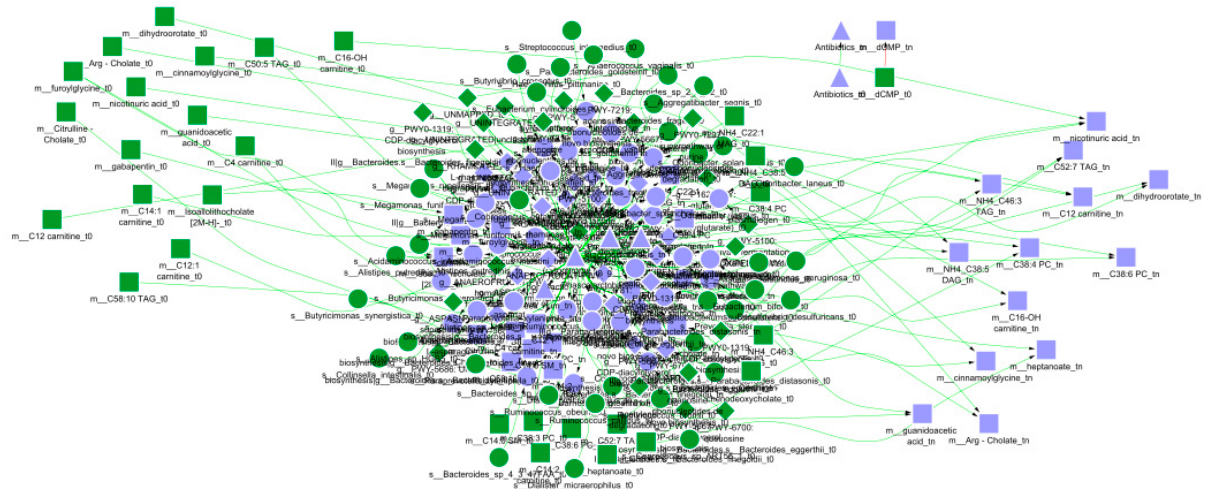
Figure 7. Learned DBN with ‘restriction matrix’ constraints on the top-50 best features per omic type. Green nodes represent time slice t i and purple nodes the consecutive t i +1. Metabolite nodes are represented by squares, species (taxa) by circles, clinical variables by triangles, and metabolic pathways by diamonds. The total number of nodes is 182, and the total number of edges is 231.